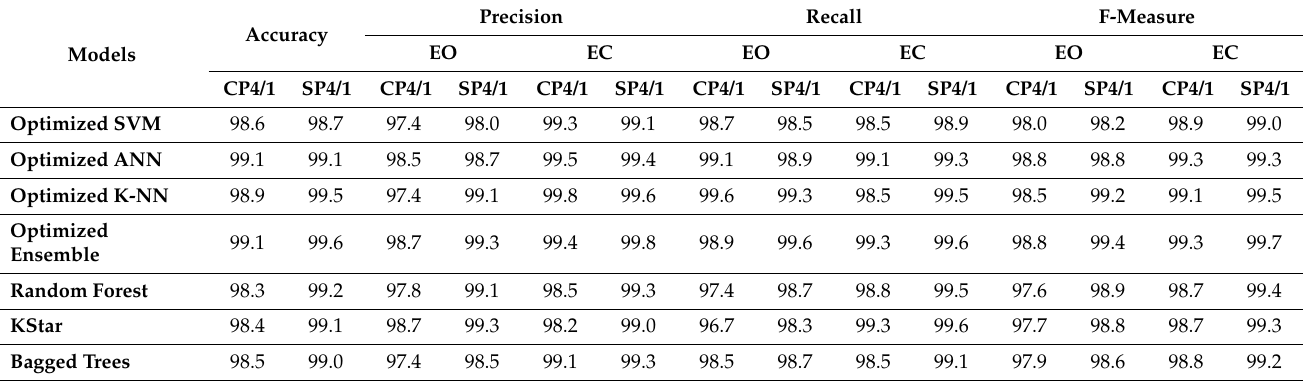
Table A5. The performance of models on evaluation measures for “comprehensively” and “simply” preprocessed datasets based on train/test split method: 40 subjects (various, randomly selected) for train/ten subjects (various, randomly selected) for test. CP4/1: CPR40-TR and CPR10-TE; SP4/1: SPR40-TR and SPR10-TE.